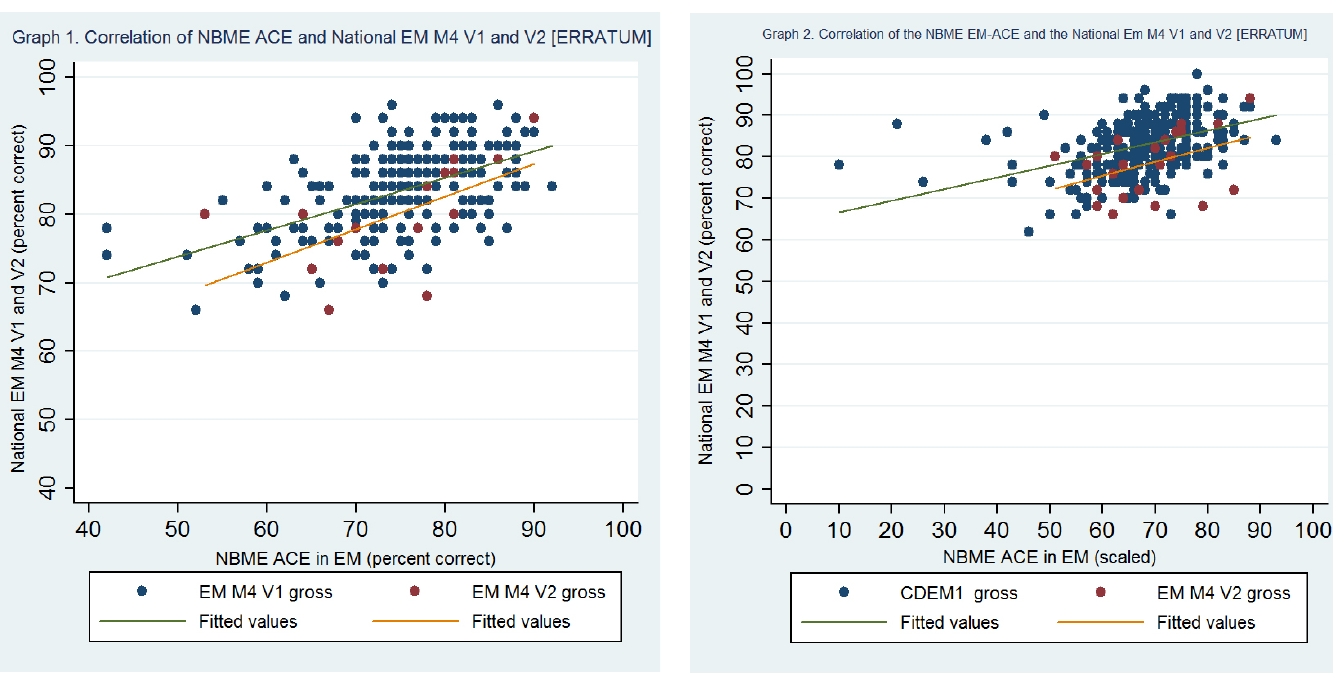
Figure 2. Correlation of NBME EM-ACE and National EM M4 V1 and